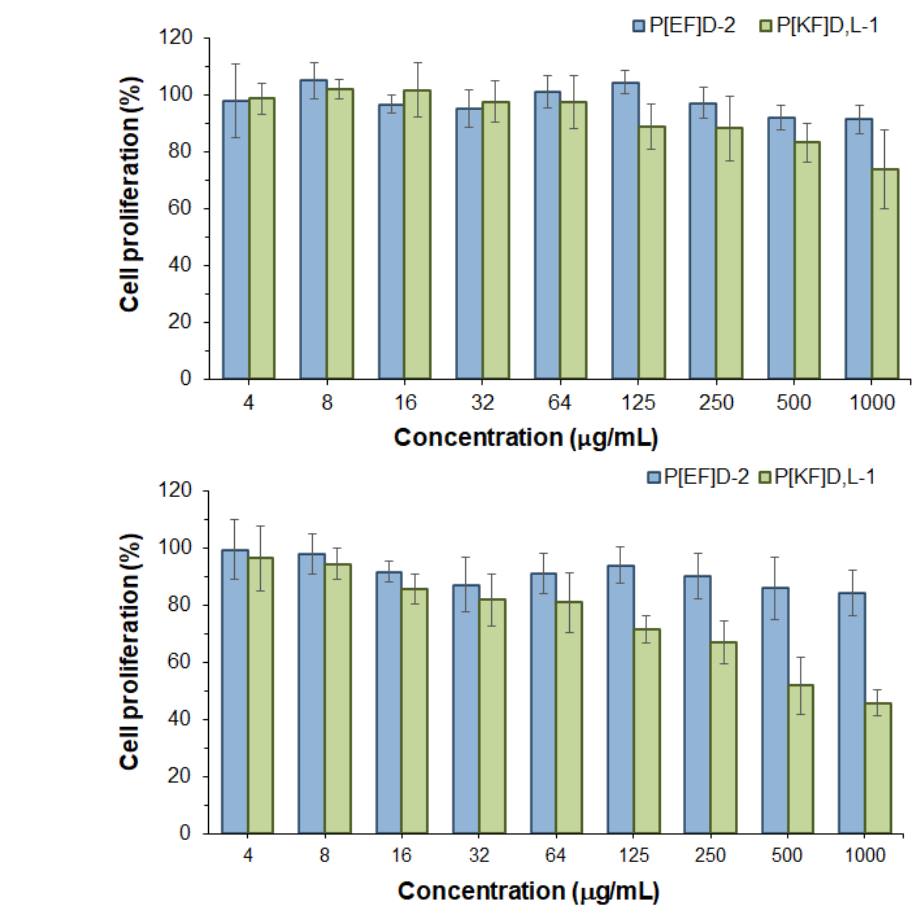
Figure 3. Effect of P[EF] D -2 and P[KF] D,L -1 nanoparticles on ARPE-19 cell proliferation for 24 h ( a ) and 72 h ( b ).